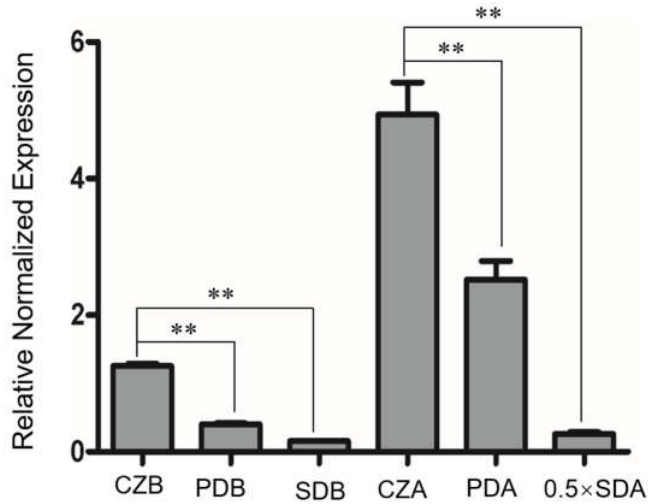
Figure 1. Gene expression analysis of BbPlin1 . Wild–type B. bassiana was cultured in liquid media including CZB, PDB, and SDB for 3 d; on solid media, CZA, PDA, and 0.5 × SDA were cultured for 7 d; and total RNA was extracted from fungal cells for use in RT–PCR experiments as detailed in the Methods section. All experiments were performed using three technical replicates and the entire experiment was performed three times. Data are given as ± SE. Stars represent statistical difference (** p < 0.01, t test).